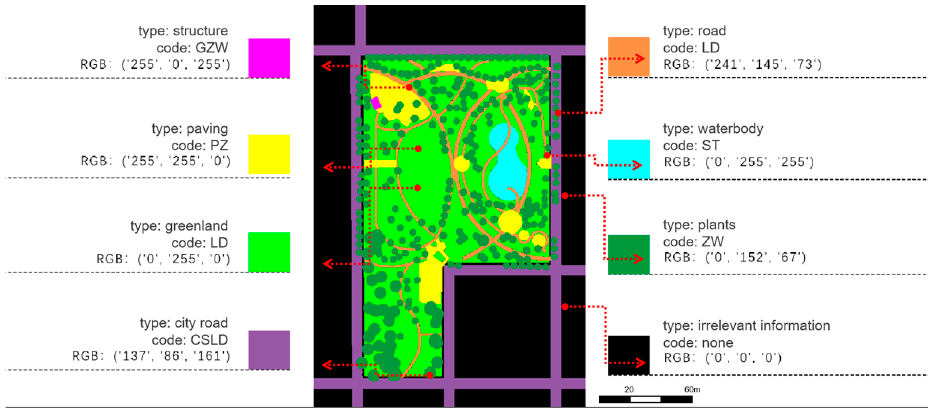
Figure 3. Image processing annotation rules.